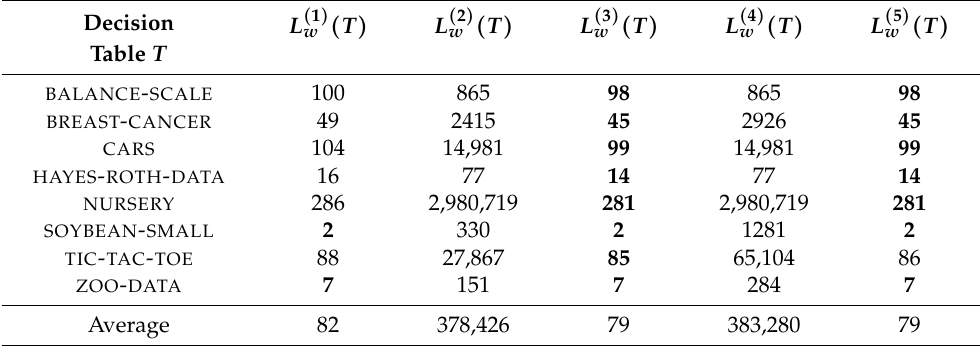
Table 8. Experimental results for decision tables from Reference [20]—number of working nodes.